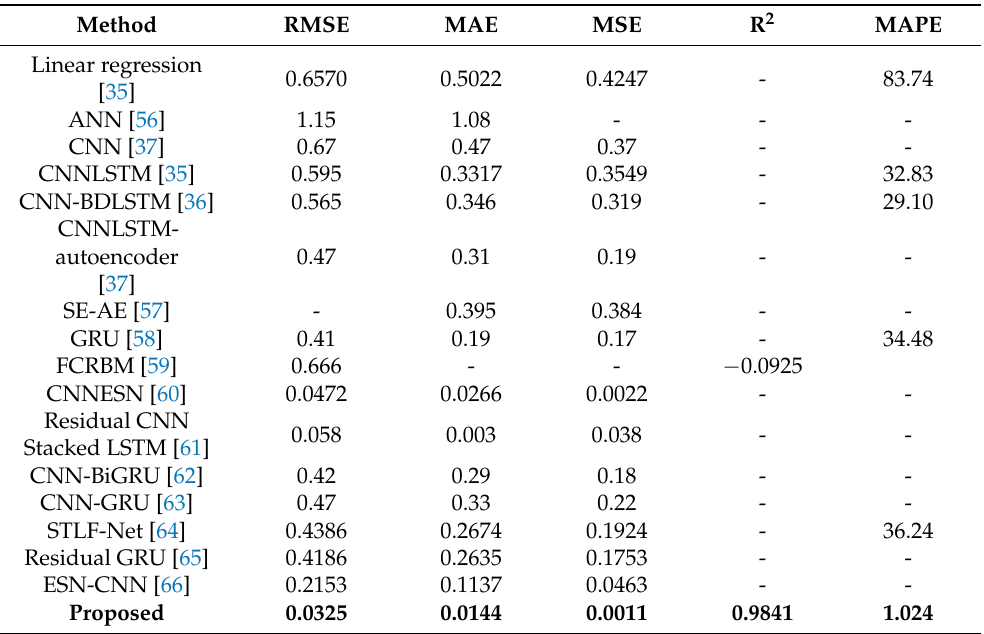
Figure 3. Visual results of R-CNN with ML-LSTM for IHEPC ( a ) hourly and ( b ) daily. Table 3. Performance comparison of R-CNN and ML-LSTM with state-of-the-art over hourly IHEPC dataset.